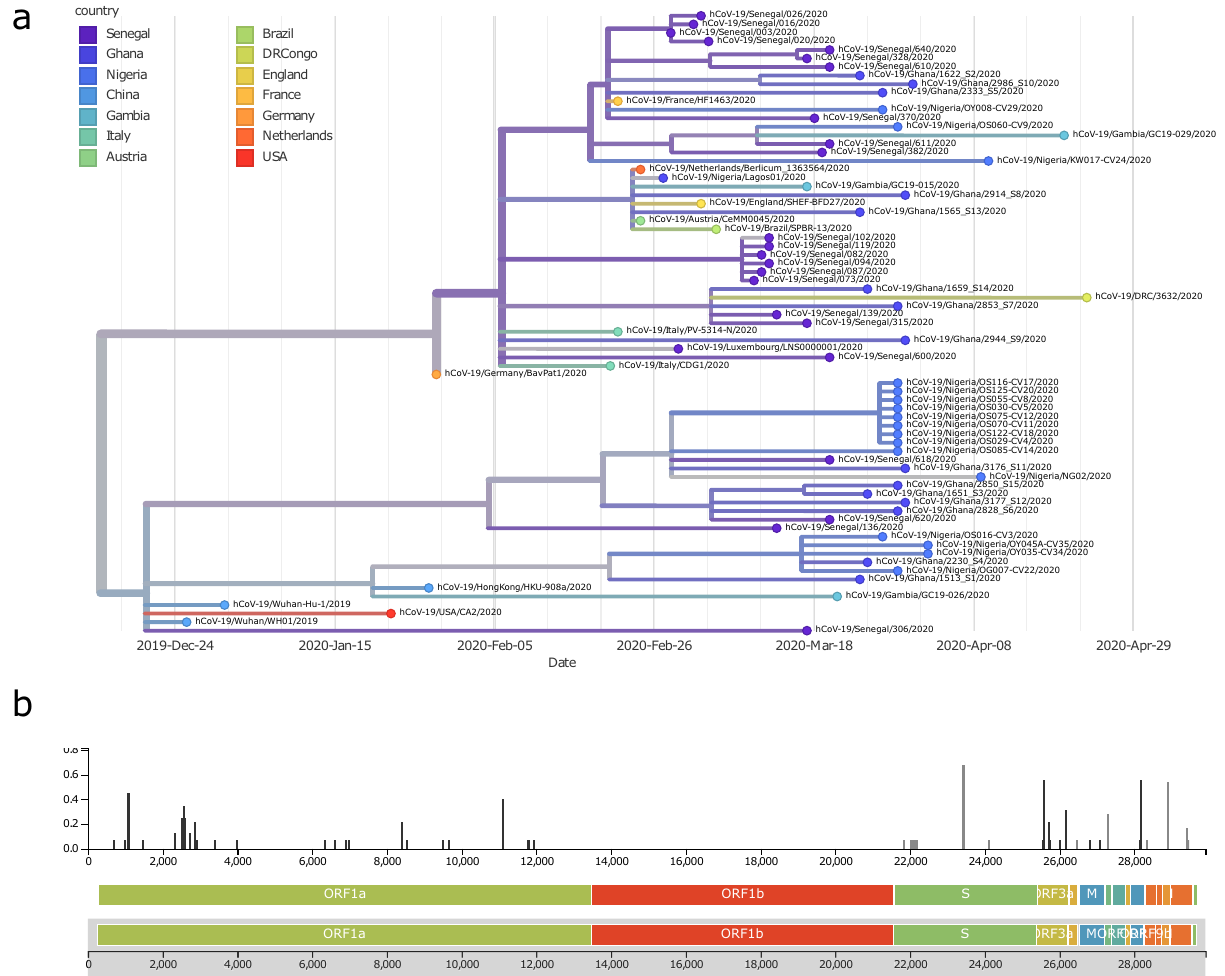
Figure 1. Phylogenetic tree (December 2019 to April 2020) revealing similarities of West-African viral sequences with Chinese and multiple European countries. ( a ) Nigerian samples cluster with the early Chinese samples within the bottom branch of the tree, Ghanaian samples are about equally distributed between the top (European) and bottom branch of the tree. Senegalese samples cluster closer with the French reference sample on the top of the tree. ( b ) Highest diversity is at the A23403G (D614G) substitution splitting the tree in the bottom (Chinese) and top (European) branch. This variant has been reported to increase infectivity 1,12 . Graphics were generated using the nextstrain pipeline including software Augur (version 7.0.2, https:// docs. nexts train. org/ proje cts/ augur/ en/ stable/ index. html) and TreeTime (version 0.7.6, https:// github. com/ neher lab/ treet ime) 28,31 Country‑specific patterns of clade distribution. Figure 4 shows that West African countries have acquired distinct patterns of China-and Europe-based clades. The first row contains the clade distribution charts of the West African countries investigated here whilst the second row contains charts of countries with compara- ble distributions. Nigeria has the highest percentage of the China-based early clades (L, S, V). Ghana has nearly equally distributed percentages of China and Europe-based clades (G, GH, GR) and in that sense has similarities with the German distribution. Senegal’s clade distribution resembles the one from France but includes also a few samples from the early China-based clades. There were only three sequences from Gambian, two from Europe- based clades GR and GH and one from China-based clade V. That pattern resembles the one from Italy when the clade G is substituted by the G-derived GH clade which however does not infer a connection to Italy but instead a similar combination of Chinese and European-related clades. Also the UK distribution in the last row shares similarities with the Gambian distribution but as it also includes Chinese clades it also resemble the one from Ghana. The Dutch distribution which is quite similar to the German also resembles the clade distribution from Ghana. Last but not least, there are the quite distinct distribution from the US West and East Coast (California, CA and New York, NY). The Californian chart has similarity with the Nigerian because of the high percentage of Chinese-based clades while the chart from New York has a comparable high percentage of clade GH as the ones from France and Senegal.